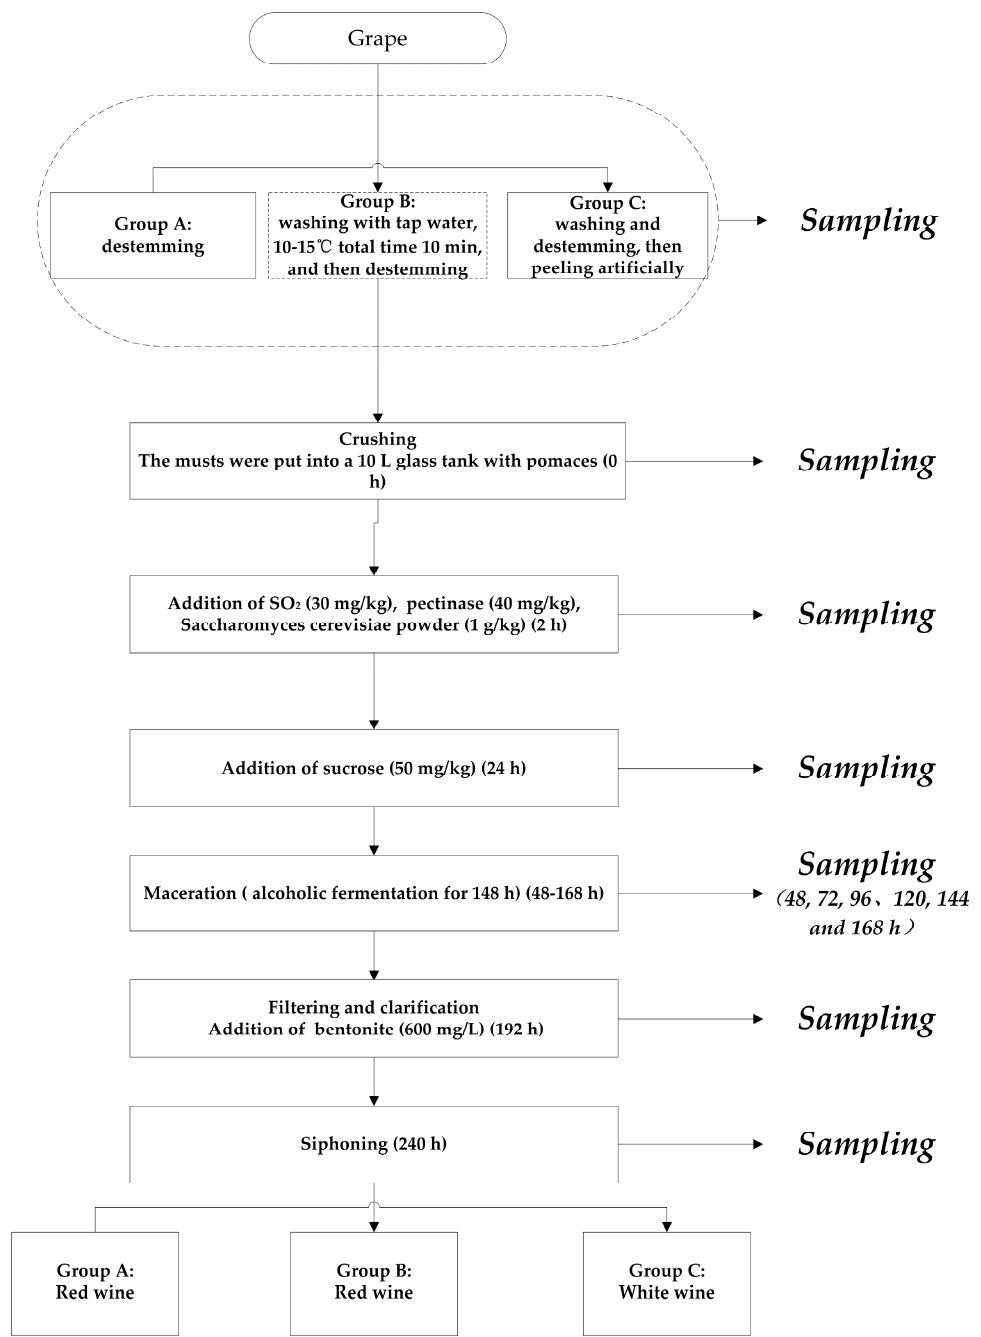
Figure 5. Scheme for wine-making process used in this study and the sampling points .